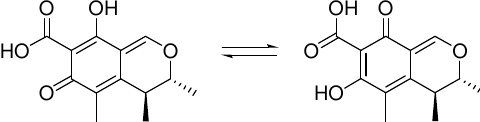
Figure 1. Chemical structures of citrinin